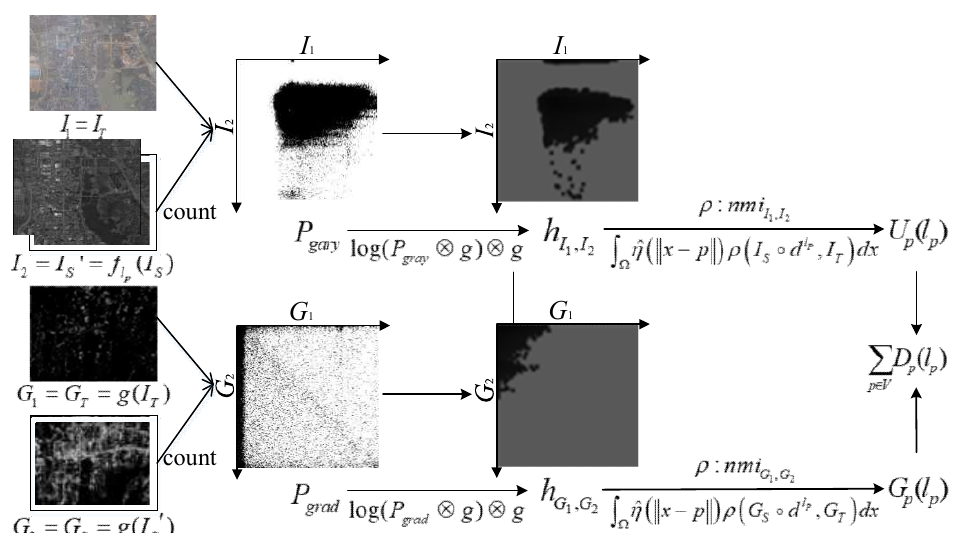
Figure 3. Overview of cost calculation visualization. Values are scaled linearly for visualization. Darker points have larger values than brighter points.